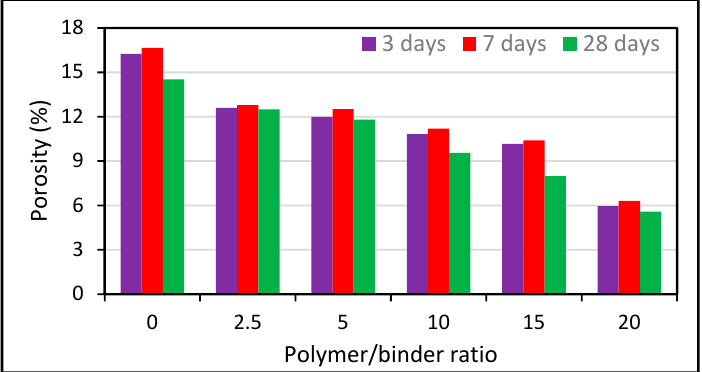
Figure 18. Porosity of a polymer-modified mix at various polymer to cement ratios and curing days [252].